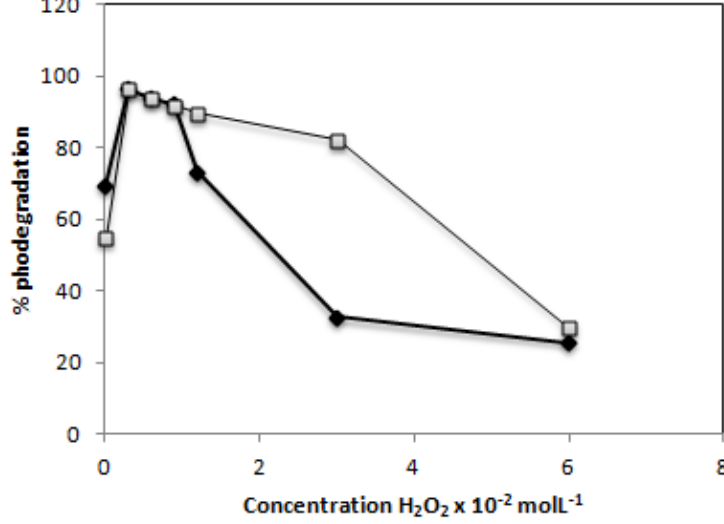
Figure 9. Effect of the presence of hydrogen peroxide on the photodegradation of C.I. Reactive Red 239 ( ) and C.I Reactive Black 5 ( ) dyes after 60 min of irradiation with 0.1 g − L − 1 of TiO and 2,60 mW/cm 2 of irradiation power by a 125 W mercury lamp. 2